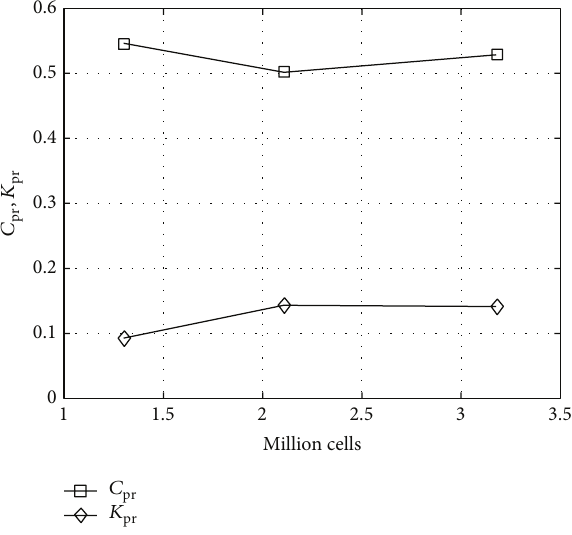
Figure 5: Diffuser pressure loss and recovery coefficients with different